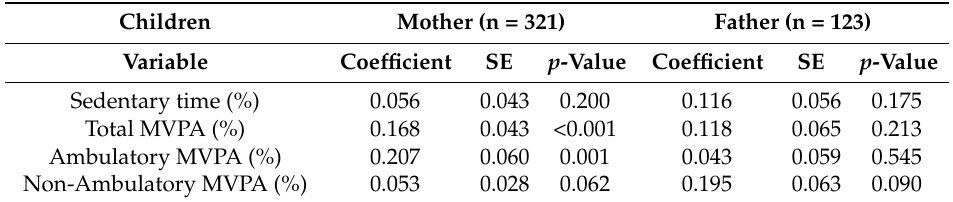
Table 3. Associations between objectively evaluated physical activity and sedentary time of children and their mothers or